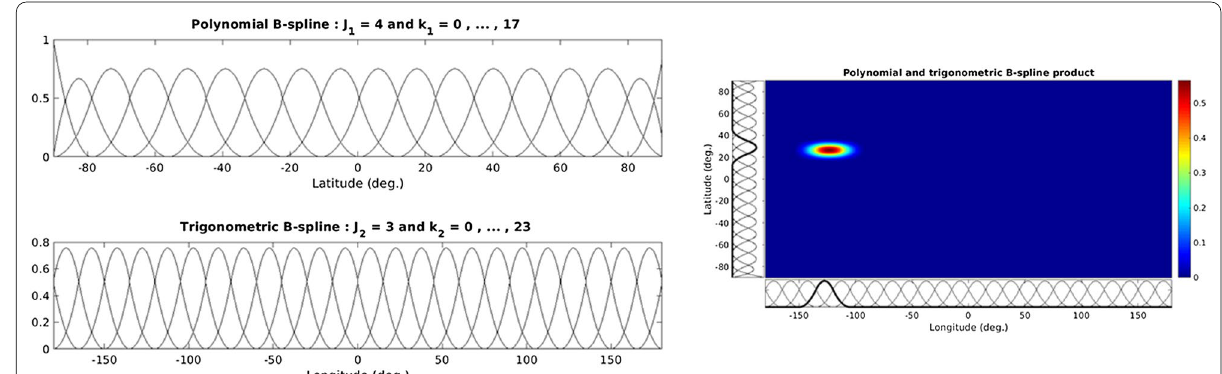
Fig. 2 2D tensor product B-spline representation of a key parameter κ r , as introduced in Eq. (11). The endpoint-interpolating B-splines (top left panel) and the trigonometric B-splines (bottom left panel) are shown for the selected level values J 1 = 4 and J 2 = 3 , respectively. Accordingly, there = 2 J 1 + 2 = 18 B-splines N 2 4, k = 3 · 2 J 2 = 24 trigonometric B-splines T 2 3, k (ϕ) with k 1 = 0,1, ... ,17 defined along the latitude and K J ( (cid:31) ) are K J 1 2 1 2 with k 2 = 0,1, ... ,23 defined along longitude between − 180 ◦ and 180 ◦ . As one of altogether 432 = 18 · 24 2D tensor product B-splines functions the right panel shows exemplarily the function N 2 4,11 (ϕ) · T 2 3,2 ( (cid:31) ) ; the non-zero region is referred to as its influence zone. Both the polynomial and trigonometric B-splines basis functions are unitless and hence their product also remains unitless in this